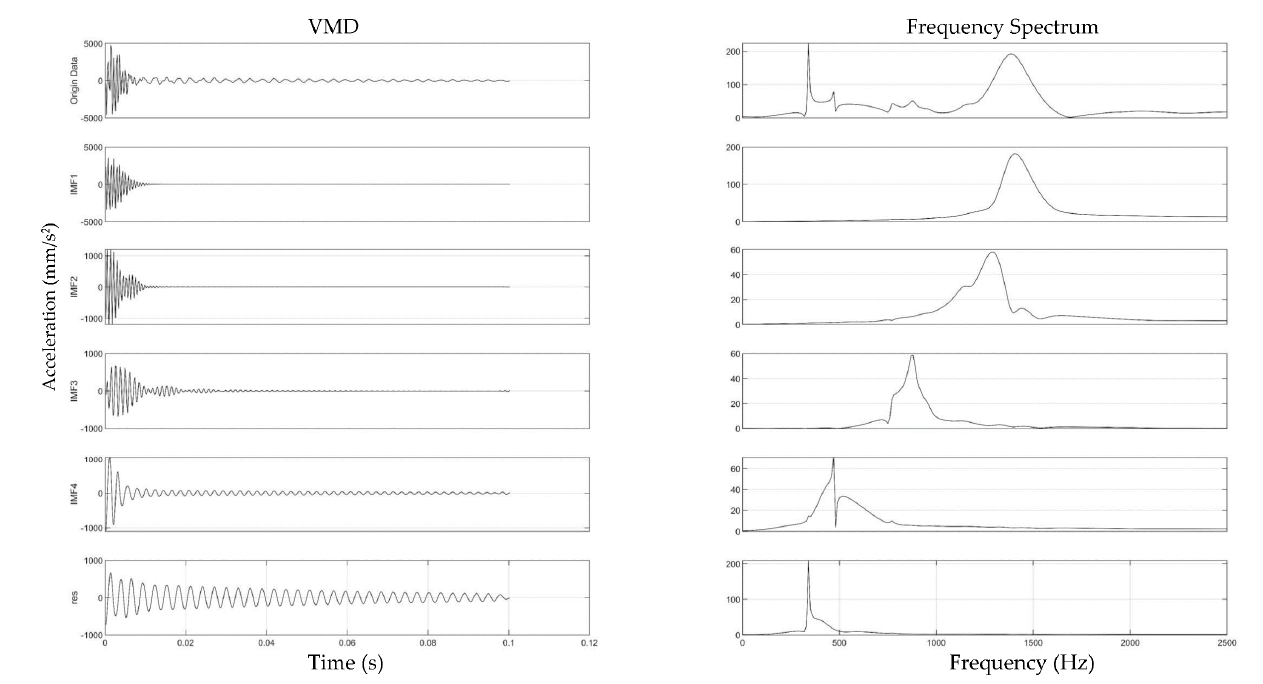
Figure 16. Acceleration response VMD decomposition (no loosening).